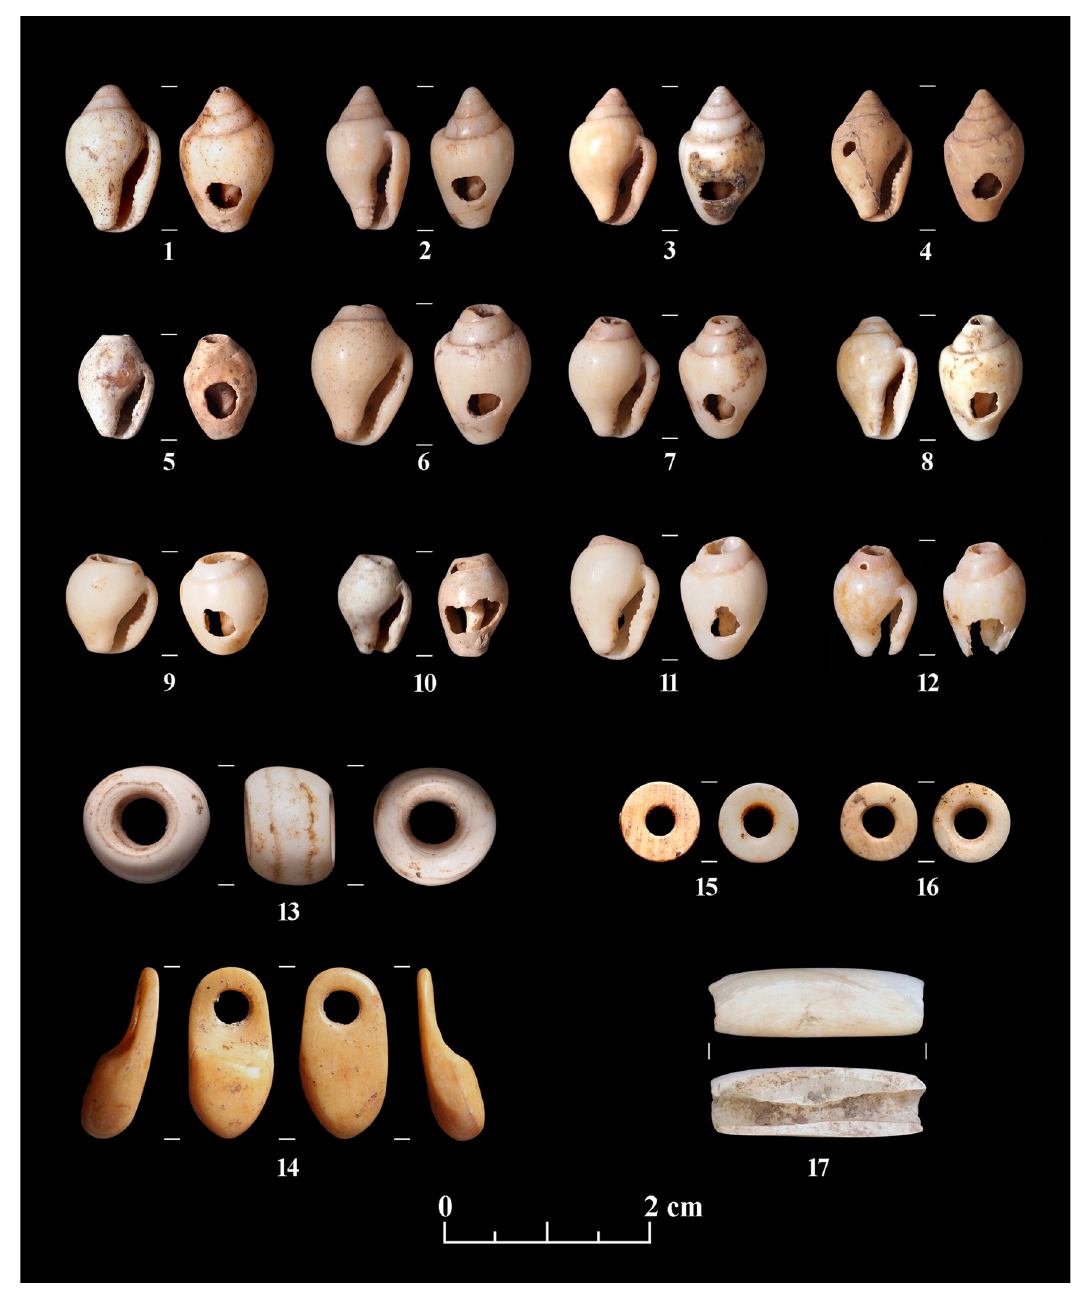
Figure 4: San Michele di Saracena Cave: ( 1 – 12 ) Columbella rustica shells; ( 13 ) perforated cave pearl; ( 14 ) bone pendant reproducing a red deer atrophic canine; ( 15 and 16 ) disc - shaped Cardium shell beads; ( 17 ) cylindrical Spondylus shell bead; ( 1 – 7 and 13 ) from Early Impressed Ware layers; ( 8 – 12 and 14 – 17 ) from Stentinello layers ( after Natali, Agrostelli, Feriozzi, Forgia, & Micheli, in press )